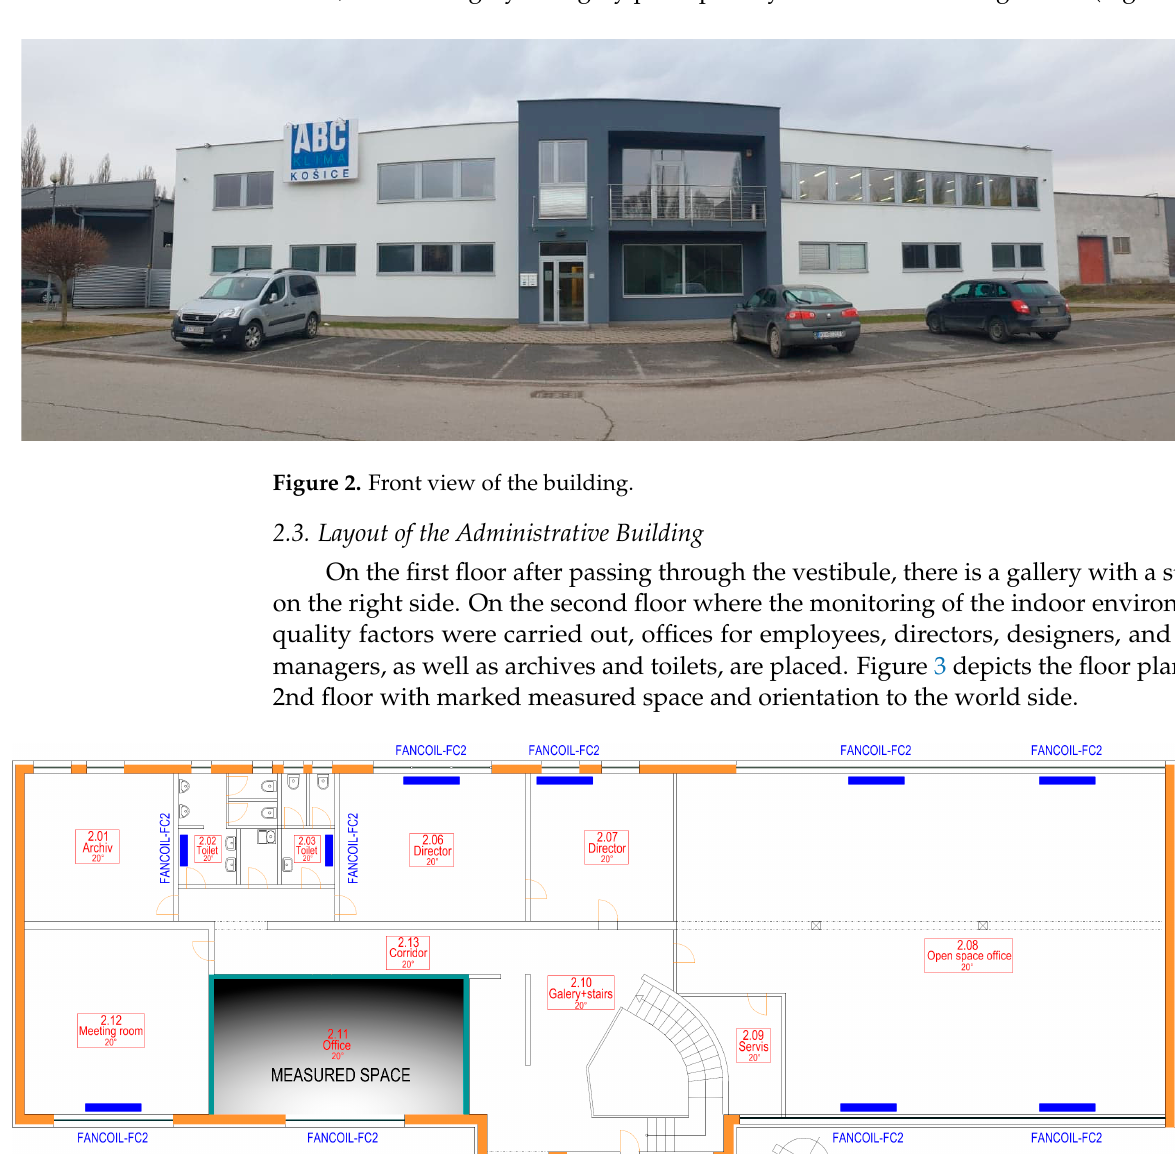
Figure 3. Floor plan of the 2nd floor.